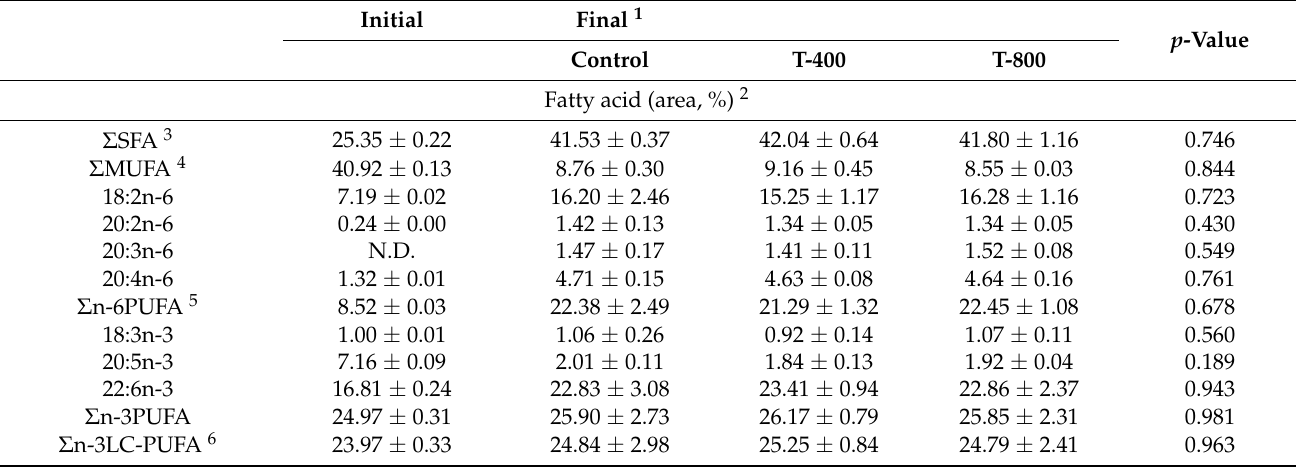
Table 5. Fatty acid composition (% of total fatty acids) of small yellow croaker larvae fed with various taurine-enriched rotifers for 15